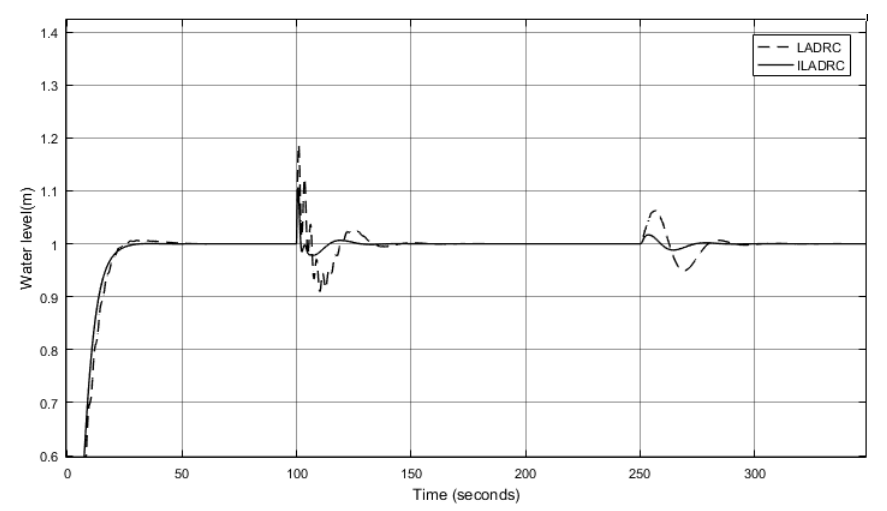
Figure 6. Simulation of LADRC and ILADRC with the model parameter G W increasing.